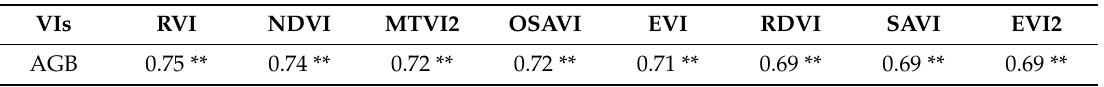
Table 5. The correlation between rape growth parameters and image